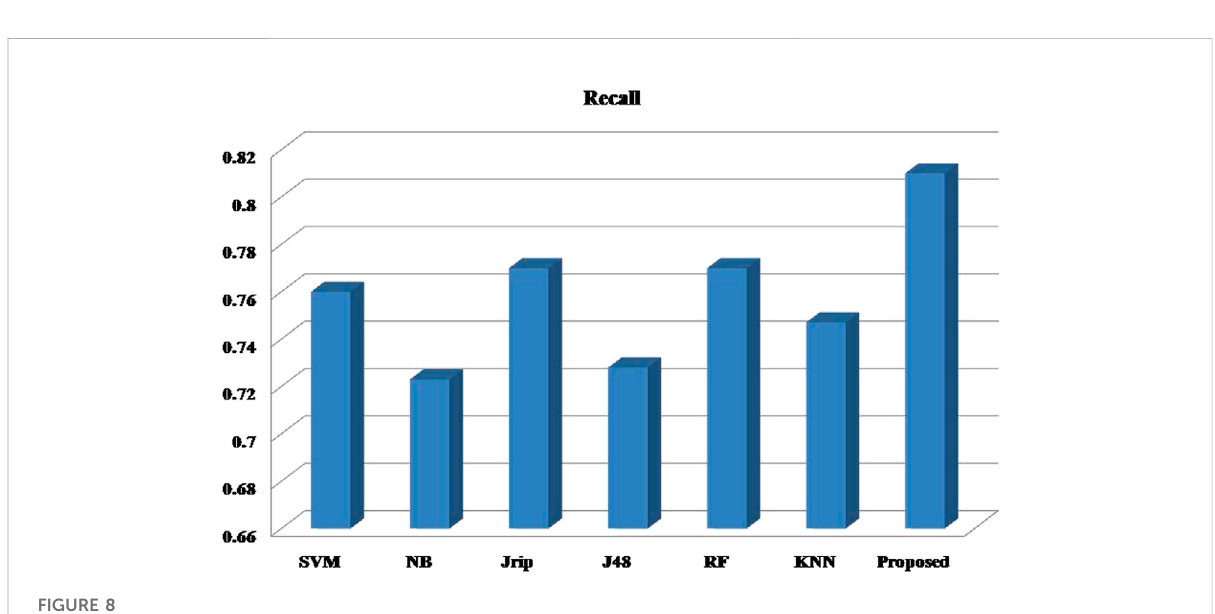
FIGURE 8 Experimental results for Recall.